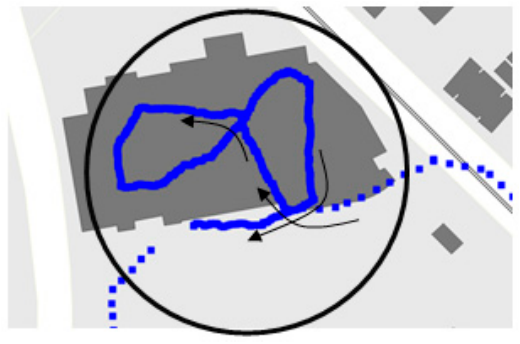
Figure 2. Time constraint must be applied when separating passing points from stay points.